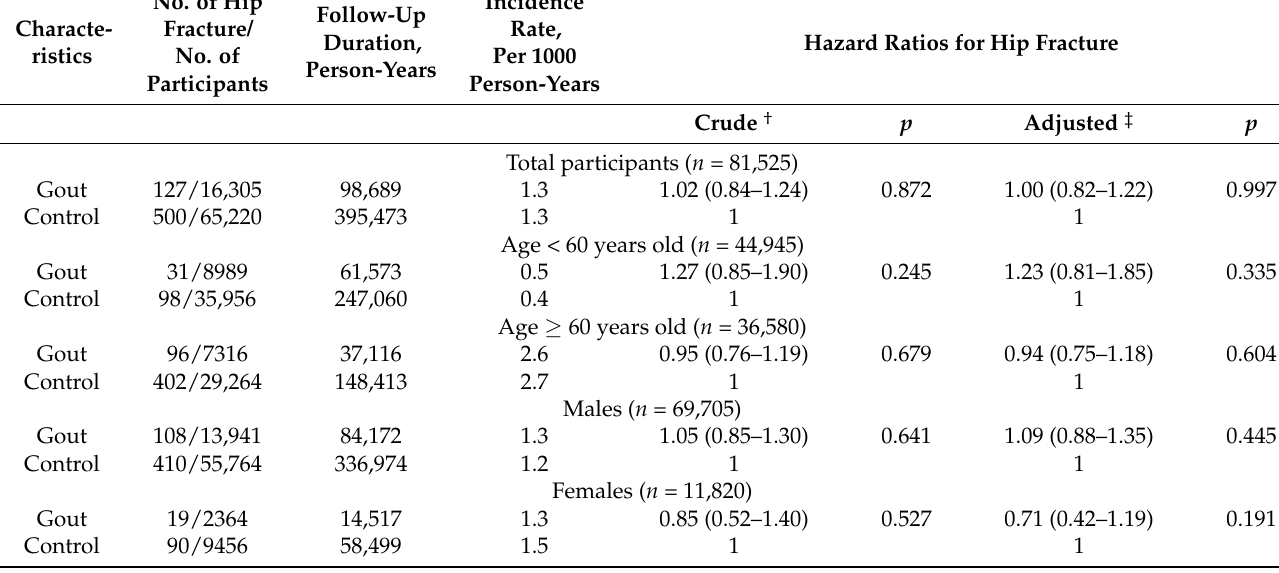
Table 4. Hazard ratio (95% confidence interval) for hip fracture in the gout and control groups with subgroup analyses according to age and